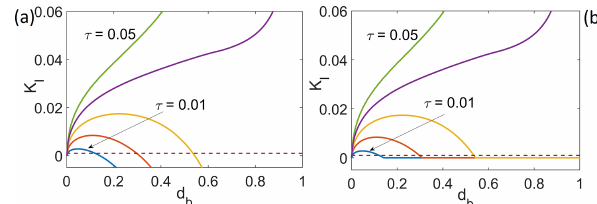
Figure 7. (a) Stress intensity factor against crack length for a basal crack for different values of τ (same plotting scheme as Fig. 2, with- out (a) and with (b) contact conditions. Panel (a) is qualitatively equivalent to Fig. 2 in van der Veen